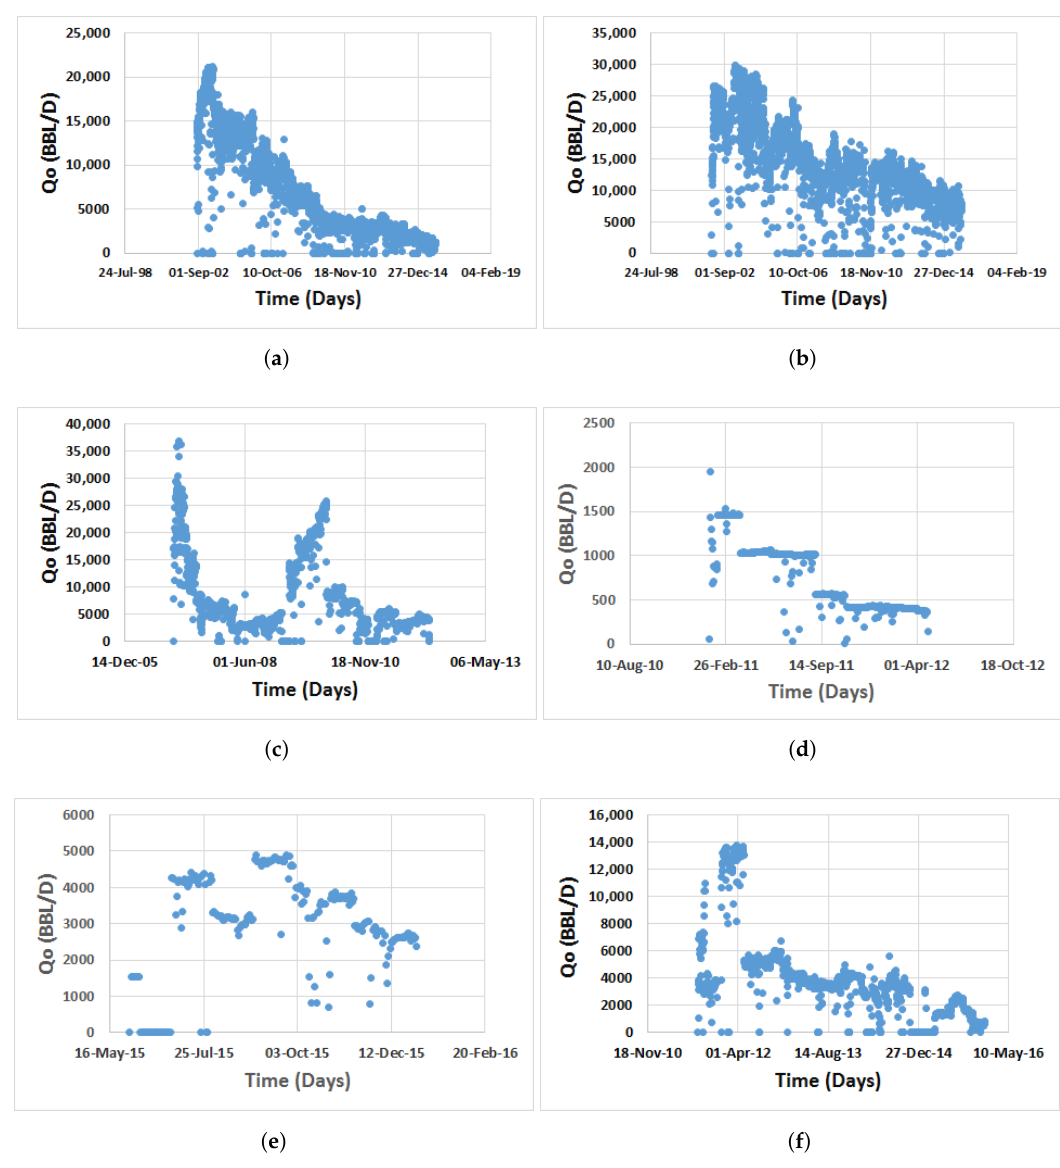
Figure 7. Production profile for wells ( a ) X6Y13W1; ( b ) X6Y16W2; ( c ) X5Y9W3; ( d ) X7Y29W4; ( e ) X8Y27W5; and ( f ) X9Y38W6. In all cases X indicates the field, Y the reservoir and W the well and the associated figures signifies the number of the field, reservoir or well in the Block K investigated (Courtesy: Sonangol